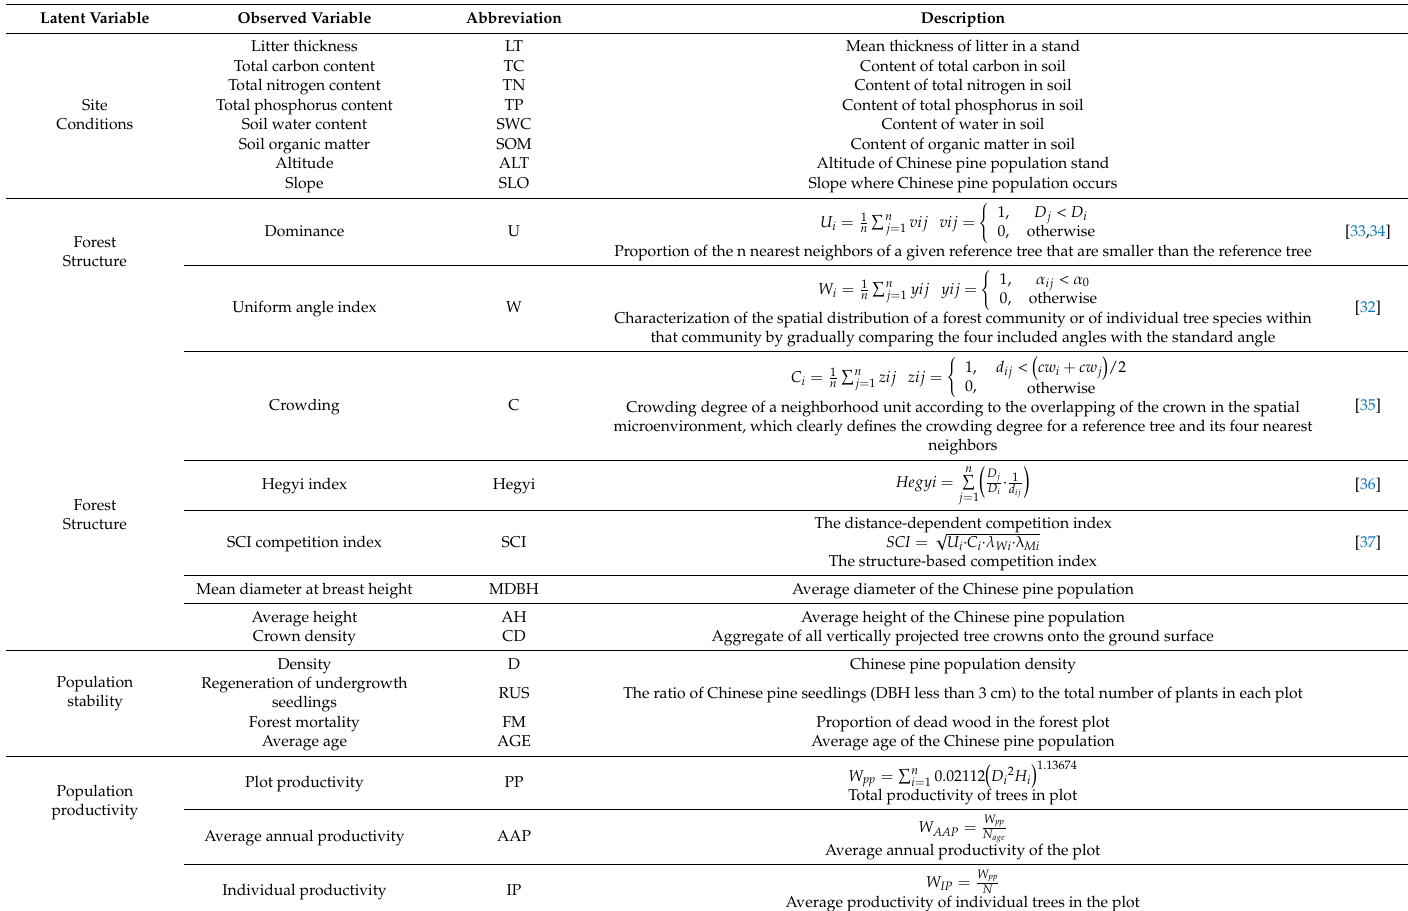
Table 3. Description of variables used in the research